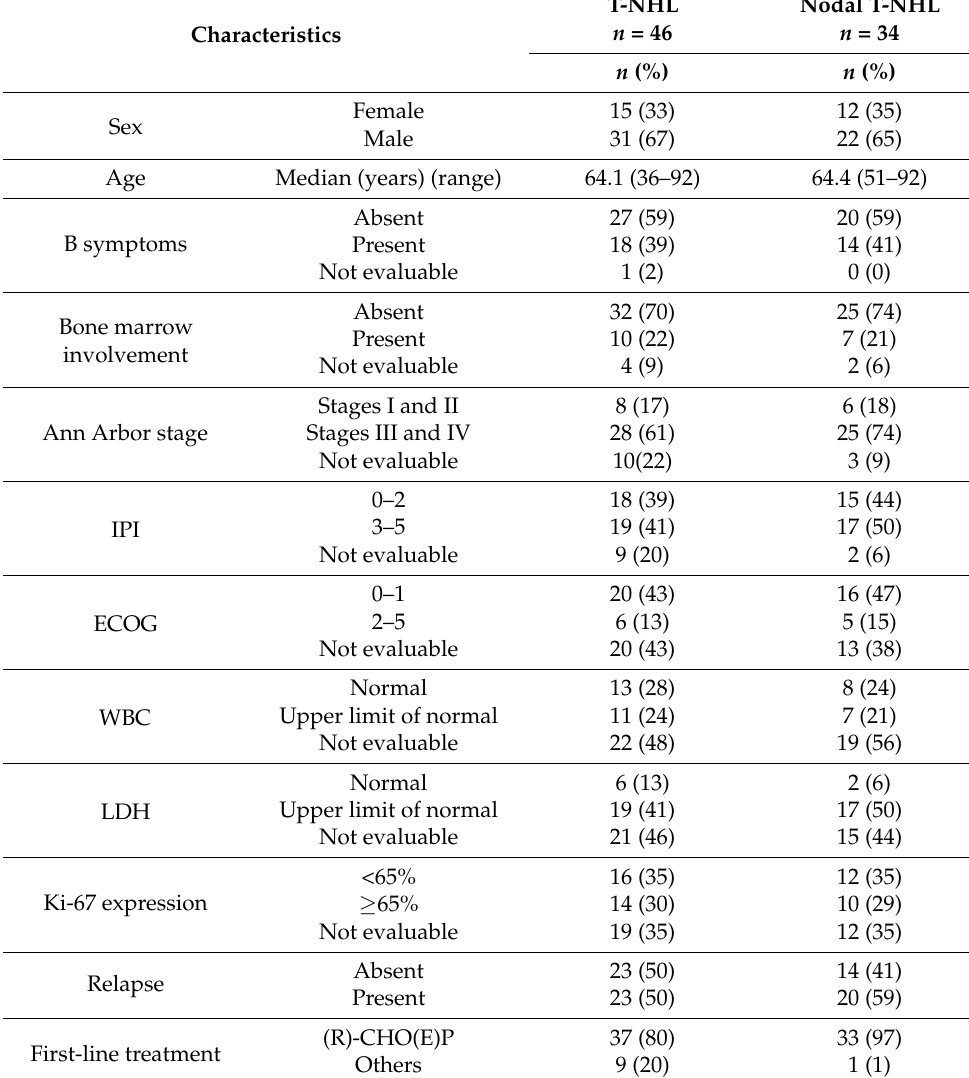
Table 2. Characteristics of tissue microarray